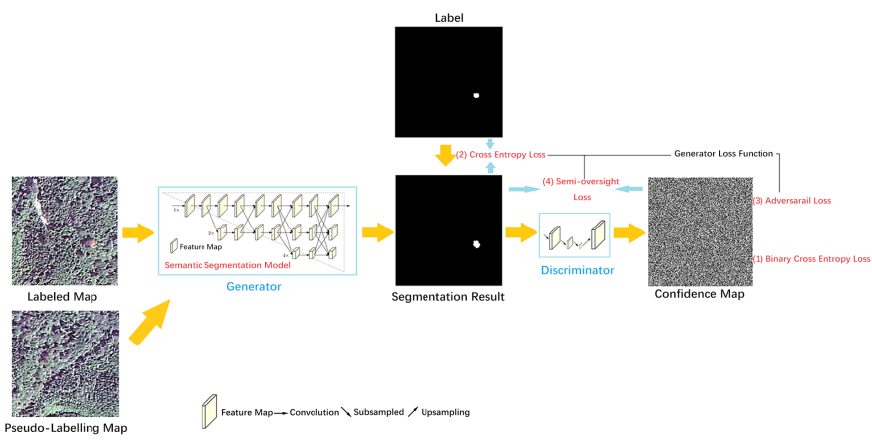
Figure 3. Semi-supervised semantic segmentation model based on GANs.